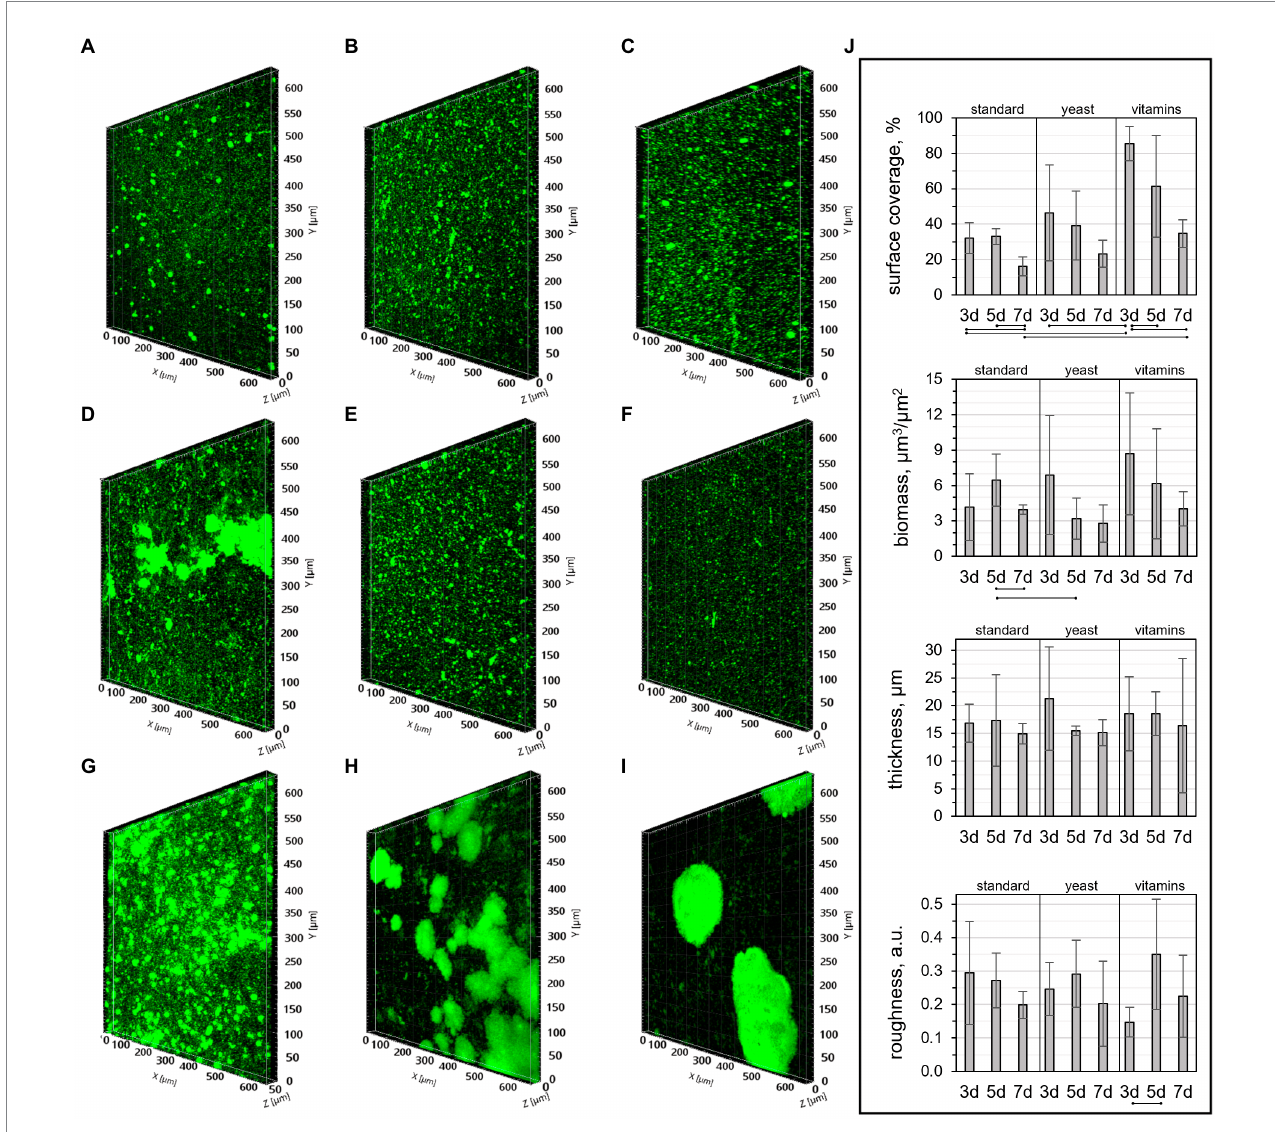
FIGURE 2 CLSM images of biofilms cultivated in (A-C) standard nutritive medium, (D-F) standard nutritive medium amended with yeast extract, and (G-I) standard nutritive medium amended with vitamins mixture for (A,D,G) three, (B,E,H) five or (C,F,I) 7 days with (j) corresponding structural parameters. The lines indicate statistically significant differences ( p ≤ 0.05) for samples prepared in the same medium, or cultivated for the same number of